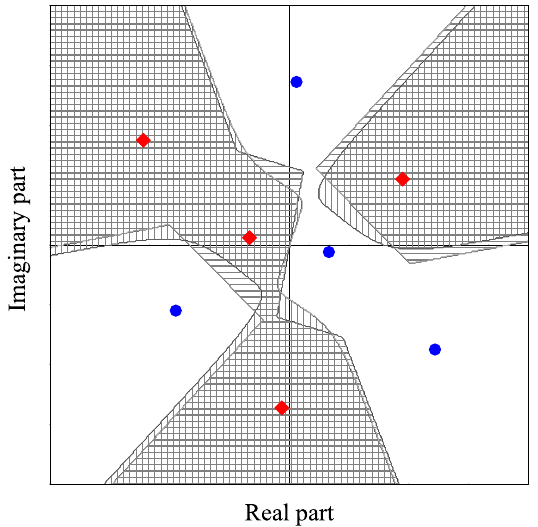
Figure 6. Received symbol constellation and decision regions for a given channel realization. Shaded areas with horizontal lines correspond to H rule. Shaded areas with vertical lines correspond to H